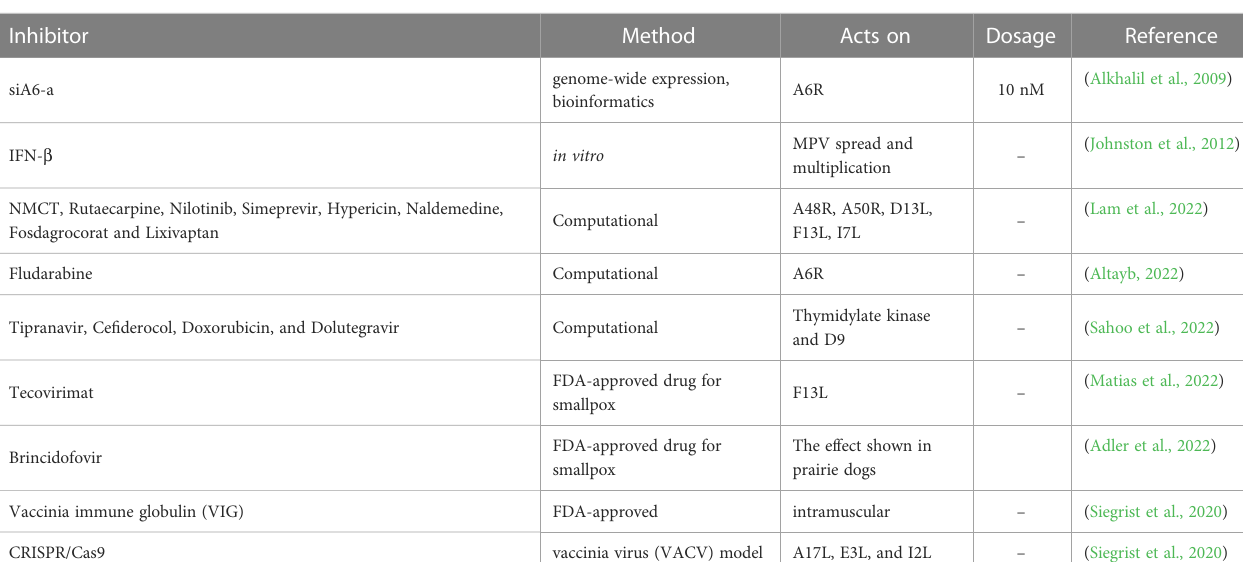
TABLE 1 Current treatments/small molecules available for MPV